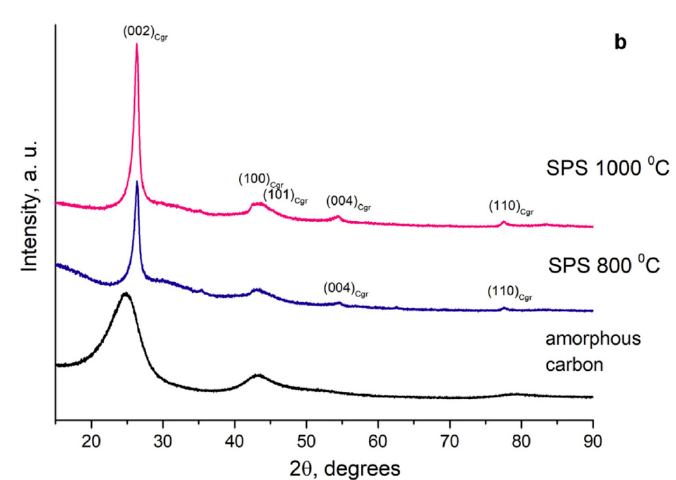
Figure 22. XRD patterns of compacts obtained by SPS of the ball-milled Co-17 wt %C mixture at 800 and 1000 °C ( a ), XRD patterns of the starting amorphous carbon (carbon black) and porous graphitized materials obtained by selective dissolution of cobalt from the sintered compacts ( b ). Reprinted from Bokhonov et al. [78], Copyright (2018), with permission from Elsevier.